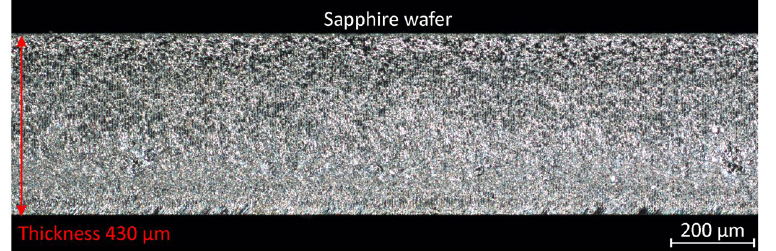
Figure 5. Image of a sapphire sidewall after laser dicing. The dark field optical microscope image of the fracture plane containing subsurface modifications induced by the dual-wavelength double-pulse laser irradiation. Four layers of merged modifications at different focus depths formed a uniform fracture plane. The lateral spacing between the laser-induced modifications was 6 μ m. Processing parameters: HWP orientation angle ϕ = 15 degrees; UV pulse energy E p355 = 2.2 μ J; IR pulse energy E p1064 = 51.5 μ J; scanning speed 600 mm/s; laser pulse repetition rate 100 kHz; pulse duration 10 ps; time delay Δ t ≈ 0.1 ns between pulses (UV prior IR); number of scans 4; focal position difference in each of the scan 90 μ m; total dicing speed 150